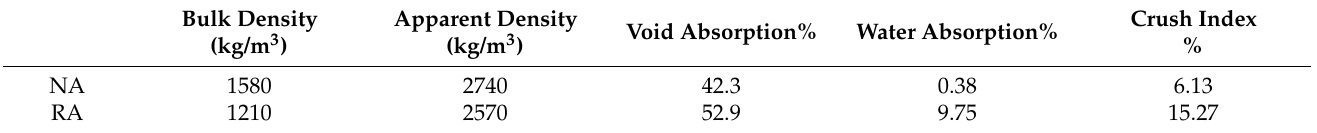
Figure 2. Morphology of the natural aggregate and recycled aggregate: ( a ) NA; ( b ) RA.